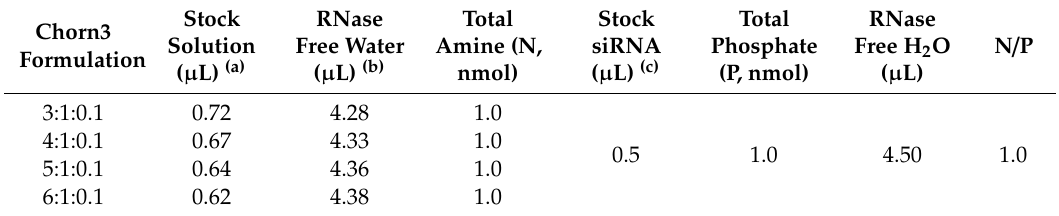
Table 1. Calculation of volume ( µ L) of each Chorn3 stock solution used to form N / P (1:1).